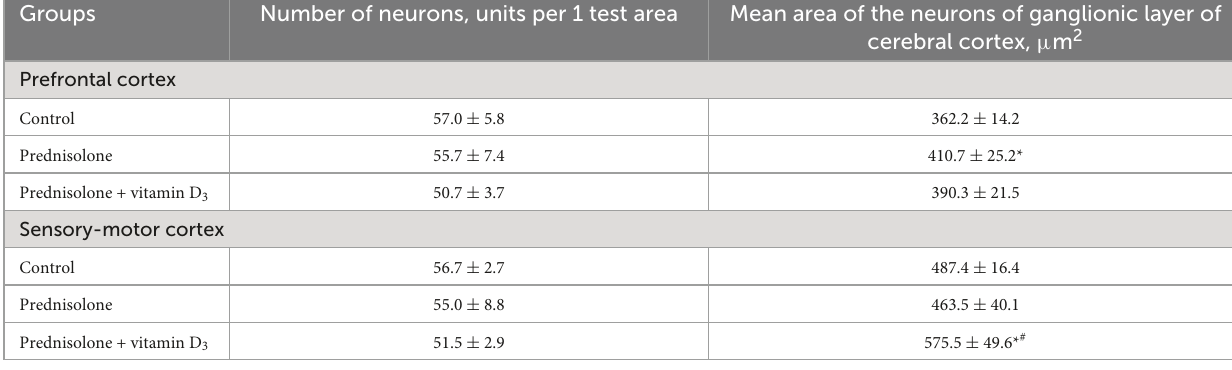
TABLE 3 Morphometric parameters of the cerebral cortex (test area 550 µ m × 215 µ m, M ± m, n = 5).